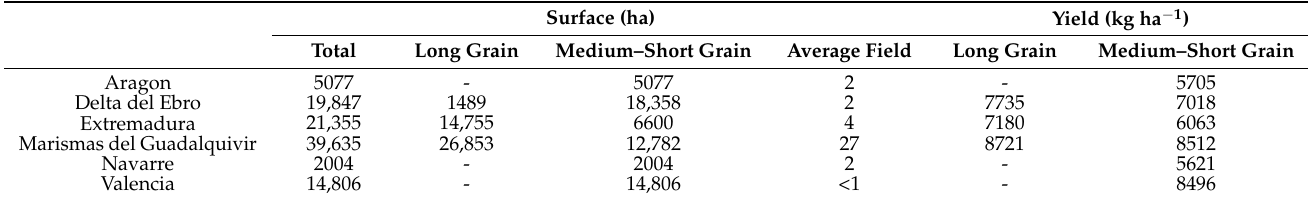
Table 1. Surface area and yield in the major Spanish rice areas. Data from